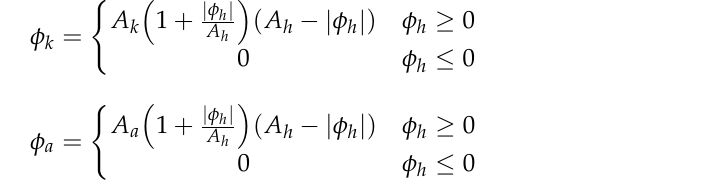
Figure 6. The gait planning of the hexapod robot.